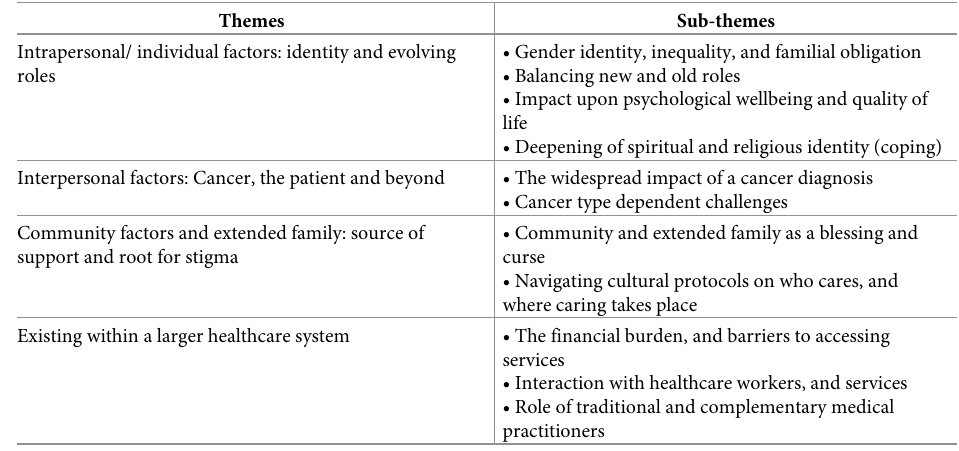
Table 4. Themes and